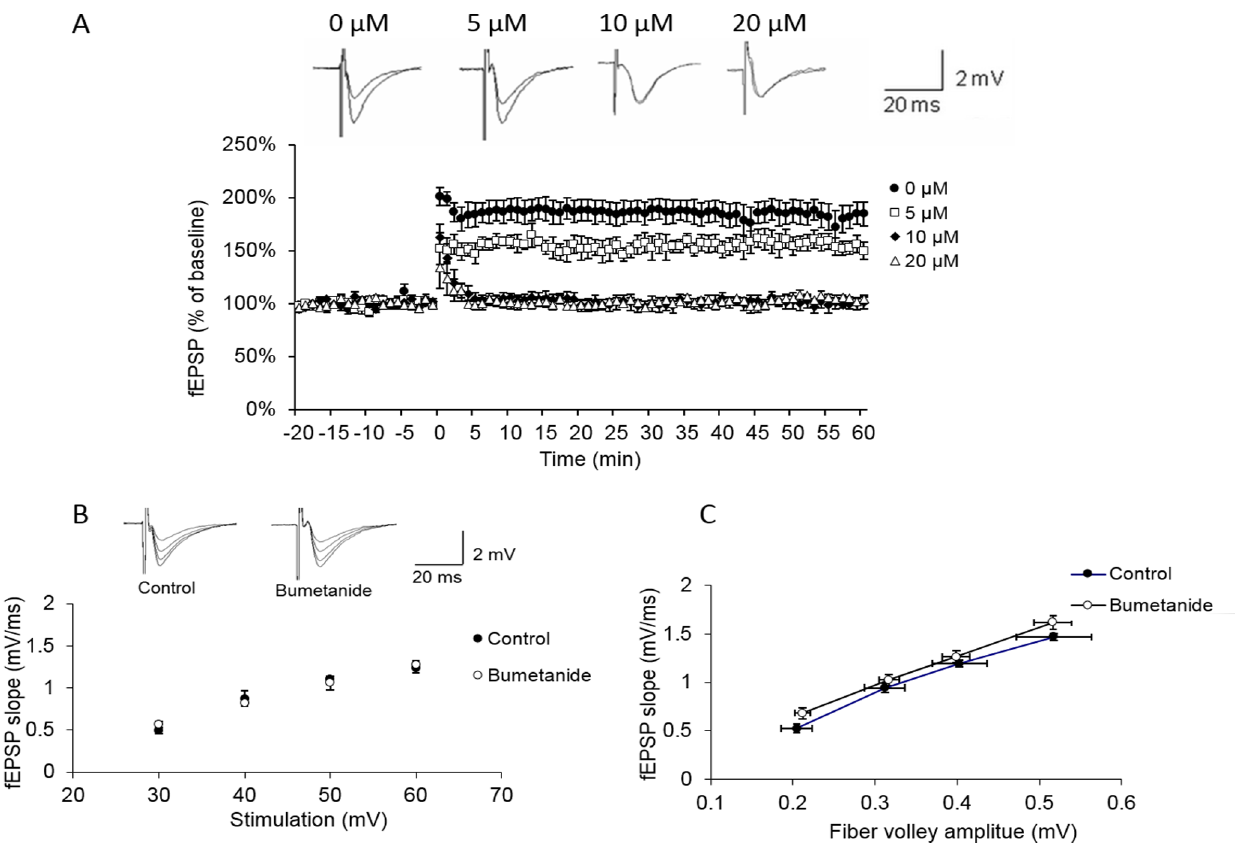
Figure 1. Superfusion of bumetanide blocked the formation of hippocampal LTP in a dose dependent manner. (A) From Left to right, representative superimposed traces of fEPSPs recorded extracellularlly under control conditions and after exposure to 0, 5, 10, and 20 m M bumetanide. Application of 10 m M bumetanide blocked LTP formation in hippocampus CA1 Schaffer collateral fiber. Bumetanide was applied from 2 10 min , 10 min. n=10 for each trial (B) fEPSP recorded in the stratum radiatum and evoked by stimulation of the Schaffer collateral—commissural pathway with different intensities in vehicle-treated and bumetanide-treated slices (10 m M). fEPSP slopes are comparable between vehicle-treated (filled circle, n=8) and bumetanide-treated (open circle, n=8) for a given range of stimulus intensities. (C) Fiber volley amplitudes are similar between vehicle-treated and bumetanide-treated (10 m M) slices for a given range of stimulus intensities.